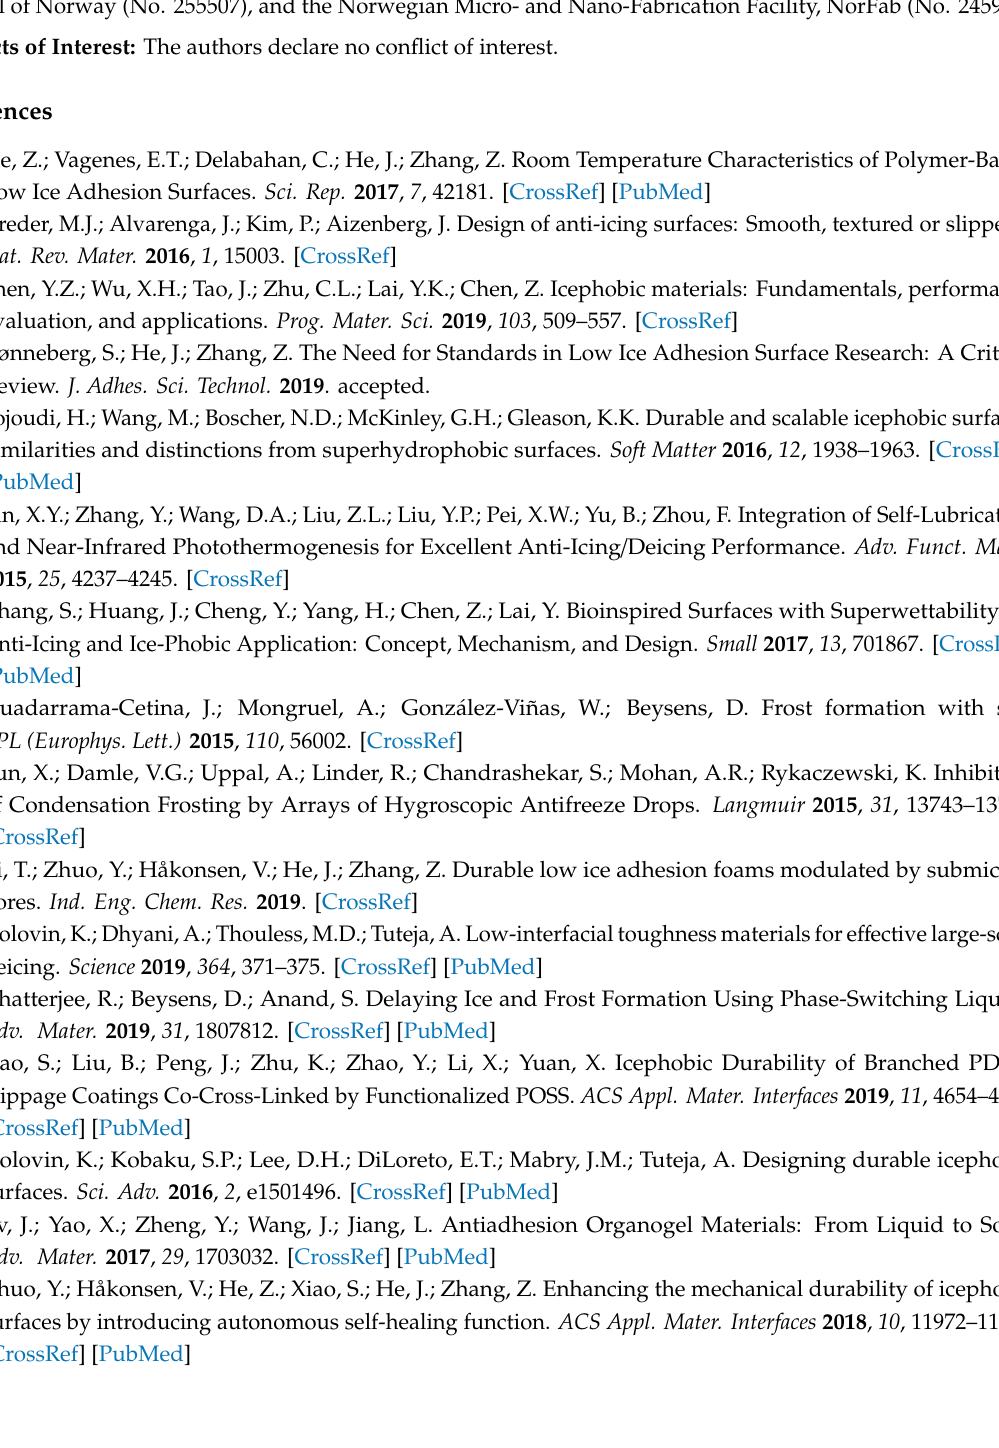
Figure S1: Cross-sectional image of frog skin, Figure S2: Schematic of fabricating the coatings, Figure S3: Pore size distribution of the 30% coating after removing the surfactant, Figure S4: Chemical structural formula of Tween 80, Span 80 and PDMS, Figure S5: Optical micrograph of 30% coating before being wiped with lens paper, Figure S6: Digital images of the water contact angels of the samples at 0 and 80 s, respectively, Table S1: Properties of coatings prepared from varied weight ratio of hybrid